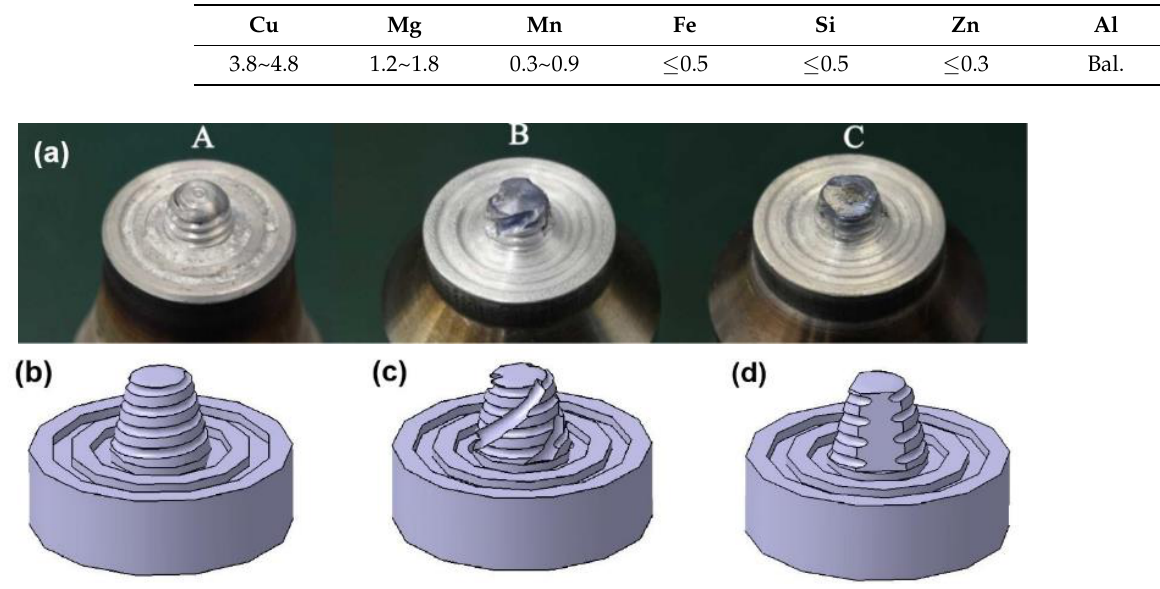
Figure 1. Image of the FSW setup. Table 1. Chemical composition of 2024 aluminum alloy (mass fraction/%).